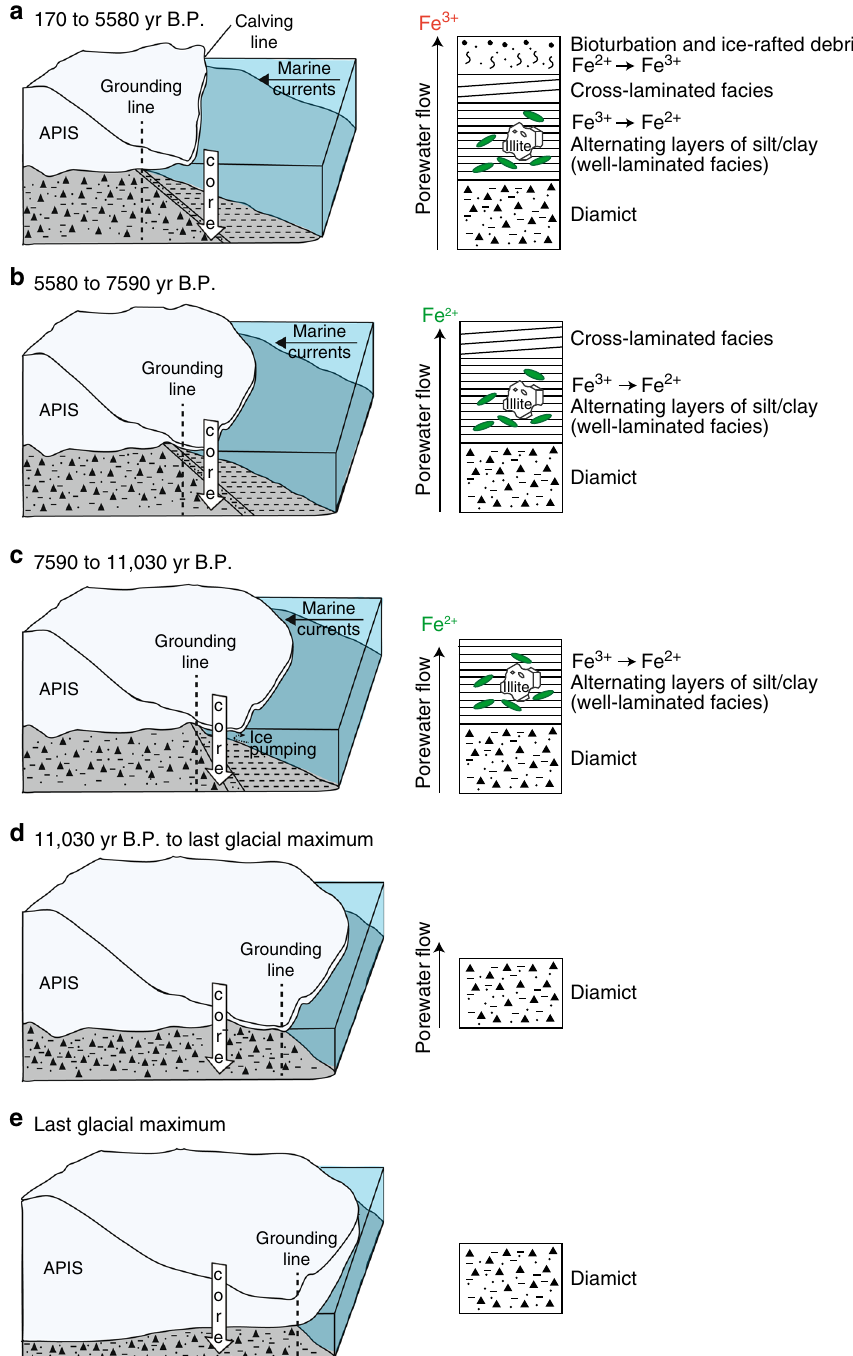
Fig. 6 Conceptual model of Larsen Ice Shelf C retreat and microbe – mineral interaction in sediments. The core site experienced fi ve different depositional settings. a Oxygenated and bioturbated sediment in open marine (170 to 5580 yr BP), b cCross-laminated layers over laminated sediment under sub-ice shelf (5580 to 7590 yr BP), c laminated sediment under sub-ice shelf (7590 to 11,030 yr BP), d diamict under subglacial (11,030 yr BP to Last Glacial Maximum), and ( e ) diamict in Last Glacial Maximum (APIS: Antarctic Peninsula Ice